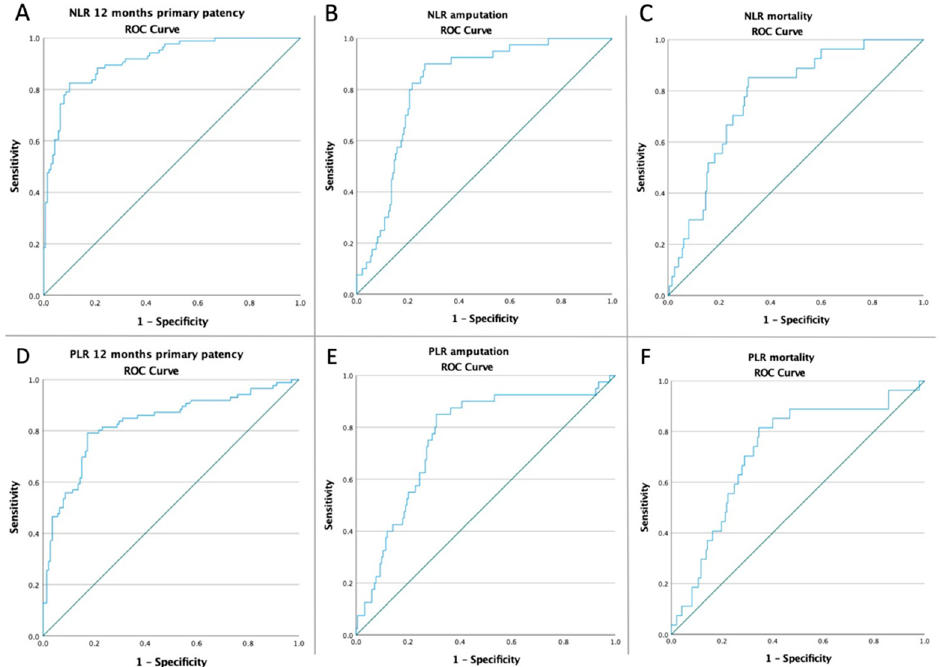
Figure 1. ROC curve analysis ( A ) for NLR concerning 12 months patency in all patients (AUC: 0.915; p < 0.001), ( B ) for NLR concerning amputation rate in all patients (AUC: 0.821; p < 0.001), ( C ) for NLR concerning the mortality rate in all patients (AUC: 0.777; p < 0.001), ( D ) for PLR concerning 12 months patency in all patients (AUC: 0.829; p < 0.001), ( E ) for PLR concerning amputation rate in all patients (AUC: 0.760; p < 0.001), and ( F ) for PLR concerning the mortality rate in all patients (AUC: